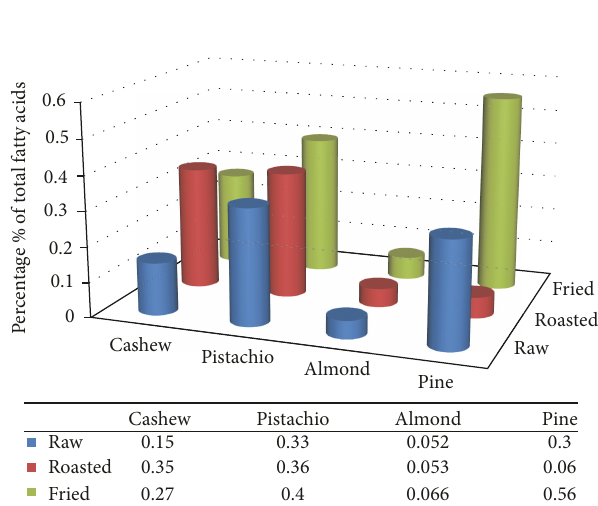
RawRoastedFried